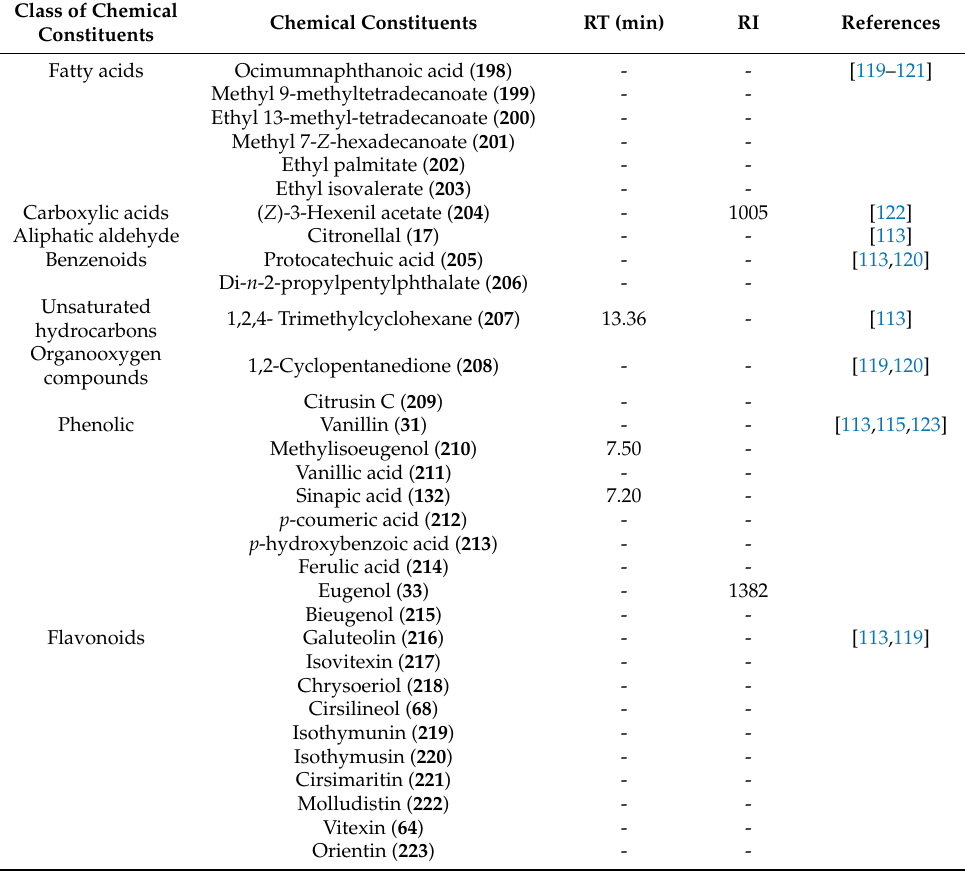
Table 5. The chemical constituents of O. sanctum